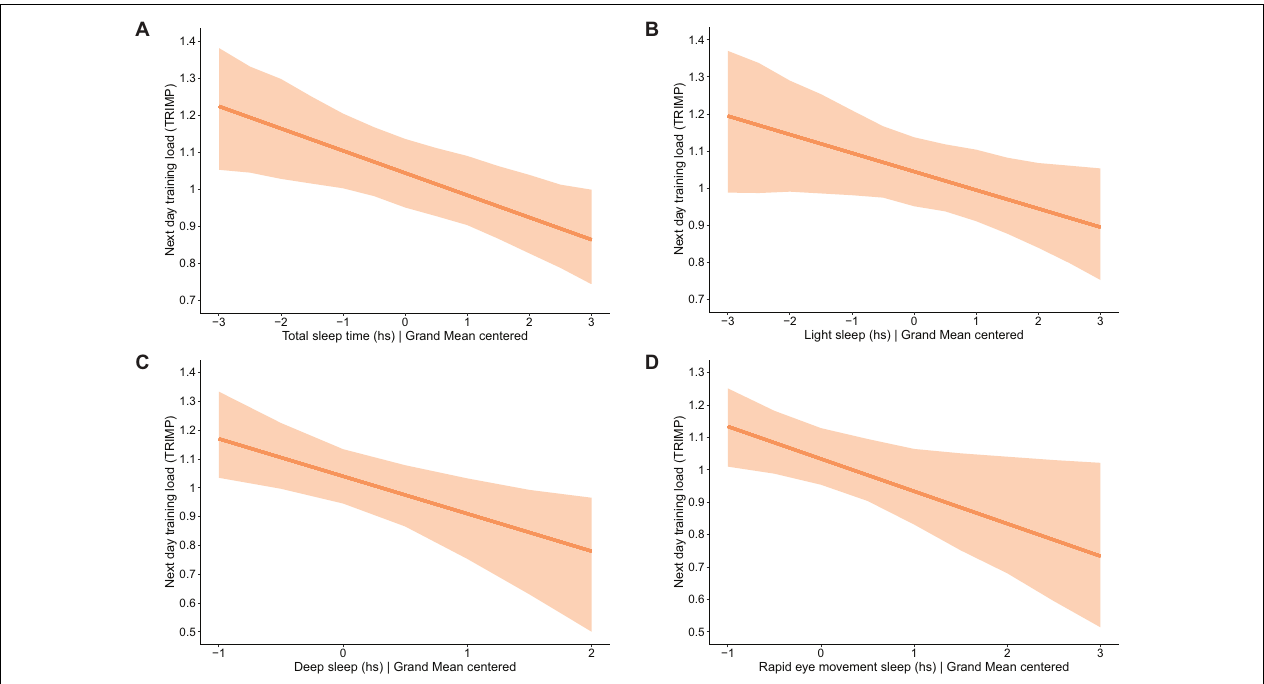
FIGURE 5 | Significant findings identified when testing the effects of sleep on mental strain and training load the next day in 56 junior endurance athletes: (A) effect of total sleep time on next day training load, (B) effect of light sleep on next day training load, (C) effect of deep sleep on next day training load, and (D) effect of rapid eye movement sleep on next day training load. The bold line represents the average intercept and slope identified in the given models. The shaded area above the line represents the upper 2.5% of 95% credibility interval, while the shaded area below the line represents the lower 2.5% of 95% credibility interval. Value 0 on the x -axis refers to the average value on the measured outcome